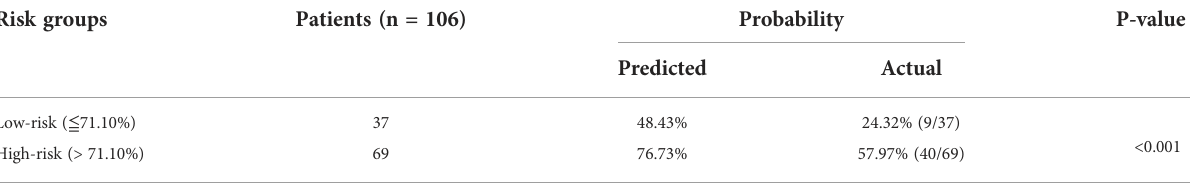
TABLE 6 Risk strati fi cation among patients in the external validation